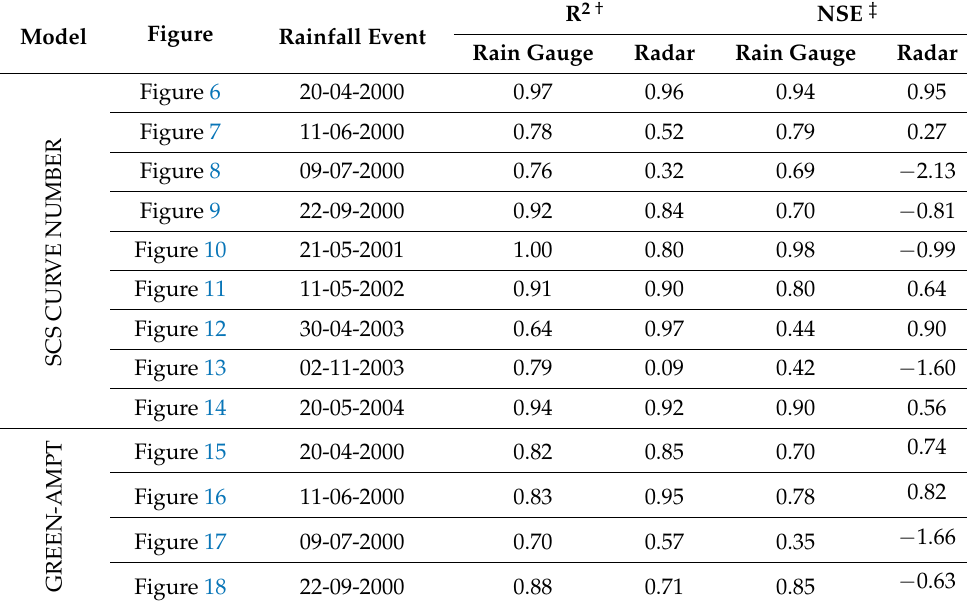
Table 14. Overall statistical comparison, Coefficient of Determination, and Nash–Sutcliffe Efficiency of stream flow using SCS curve number method and Green and Ampt method using different rainfall inputs.